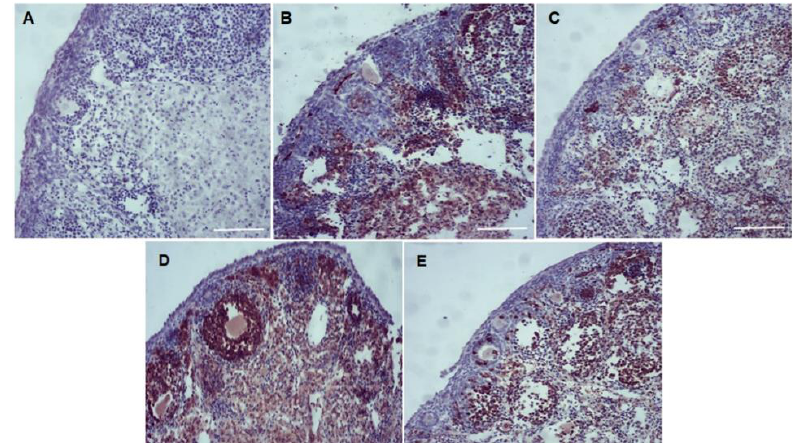
Figure 7. Immunohistochemical staining for caspase-3 in mice ovaries before ( A ) and after culture in vitro for 6 days in the presence or absence of CIMI or DOXO ( B – E ): ( A ) negative control; ( B ) control group (DMEM + ); ( C ) CIMI (5 ng/mL); ( D ) DOXO (0.3 μg /mL); ( E ) and CIMI + DOXO. (100× — Scale bar: 100 µm).